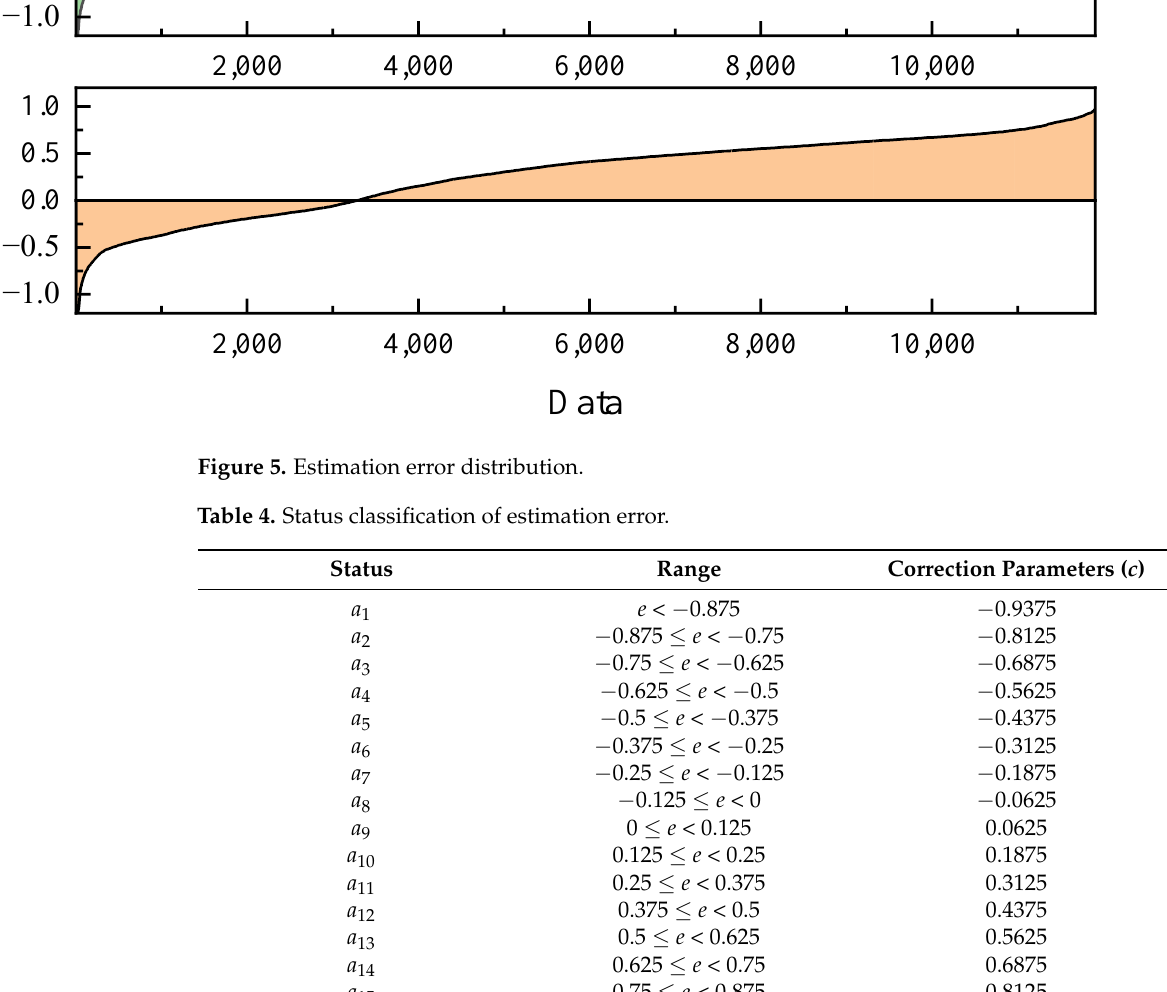
Table 4. Status classification of estimation error.